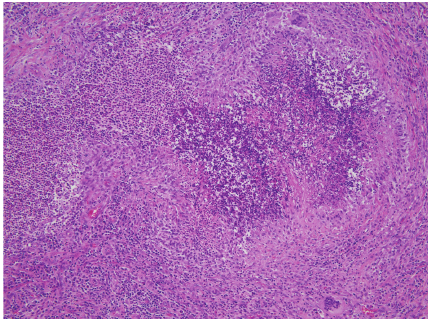
Figure 2: Parenchymal necrosis with palisading granuloma, necro- tizing vasculitis, and mixed inflammatory infiltrates, characteristic of GPA (hematoxylin and eosin, 100x original